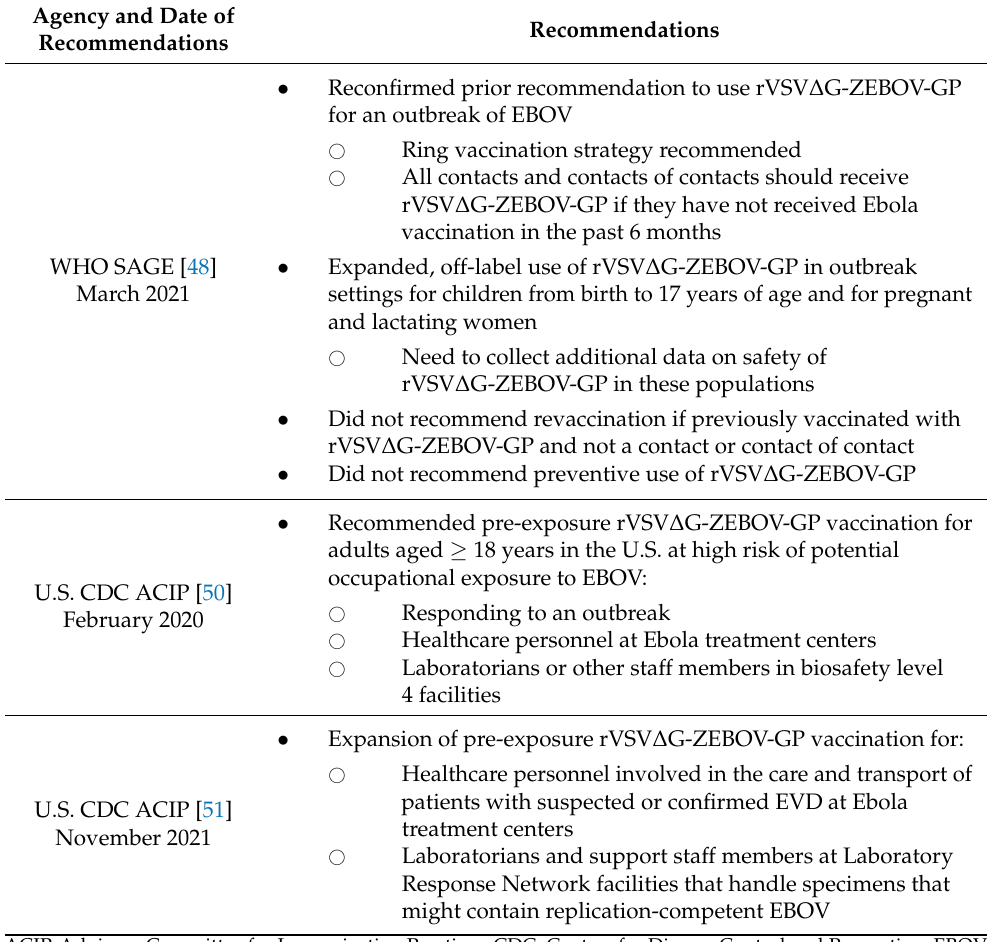
Table 1. Recommendations for rVSV ∆